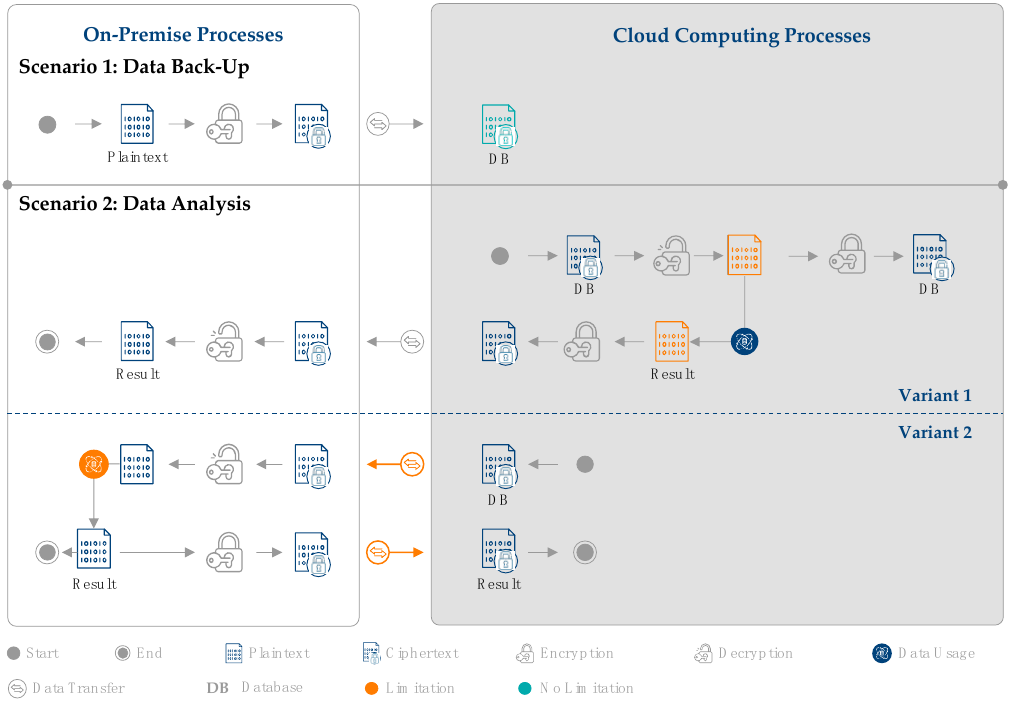
Figure 3. Limitations of classic encryption during cloud computing.